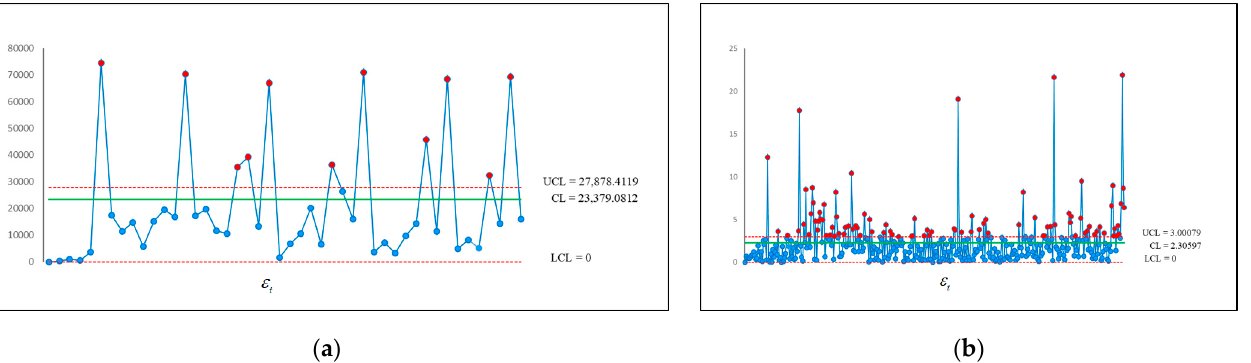
Figure 1. Graphical displays of the illustrative for the proposed formula running modified EWMA charts applied to the dataset: ( a ) Application 1; ( b ) Application 2.